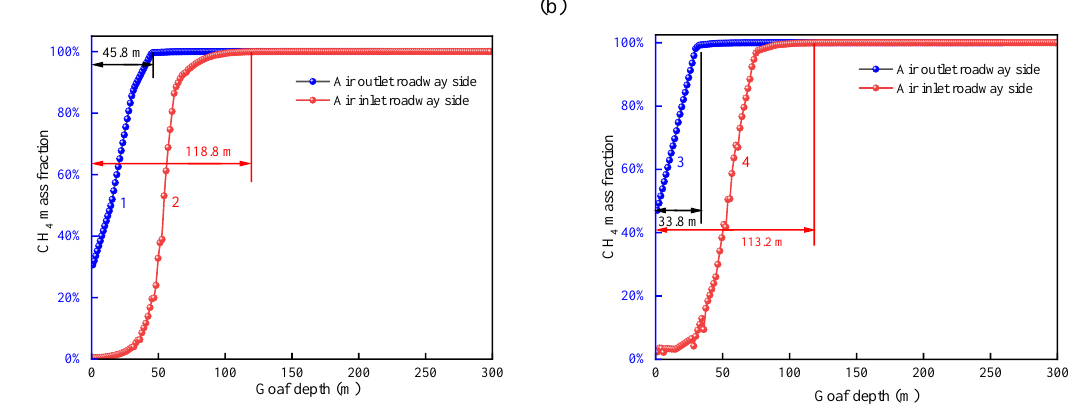
Figure 5. Comparison diagram of the gas mass fraction at the side of air outlet roadway and air inlet roadway ( a ) caving zone and ( b ) fractured zone.